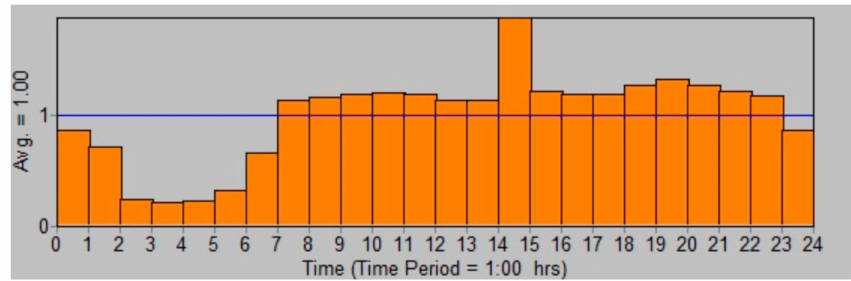
Figure 5. Daily water consumption pattern for a selected industrial